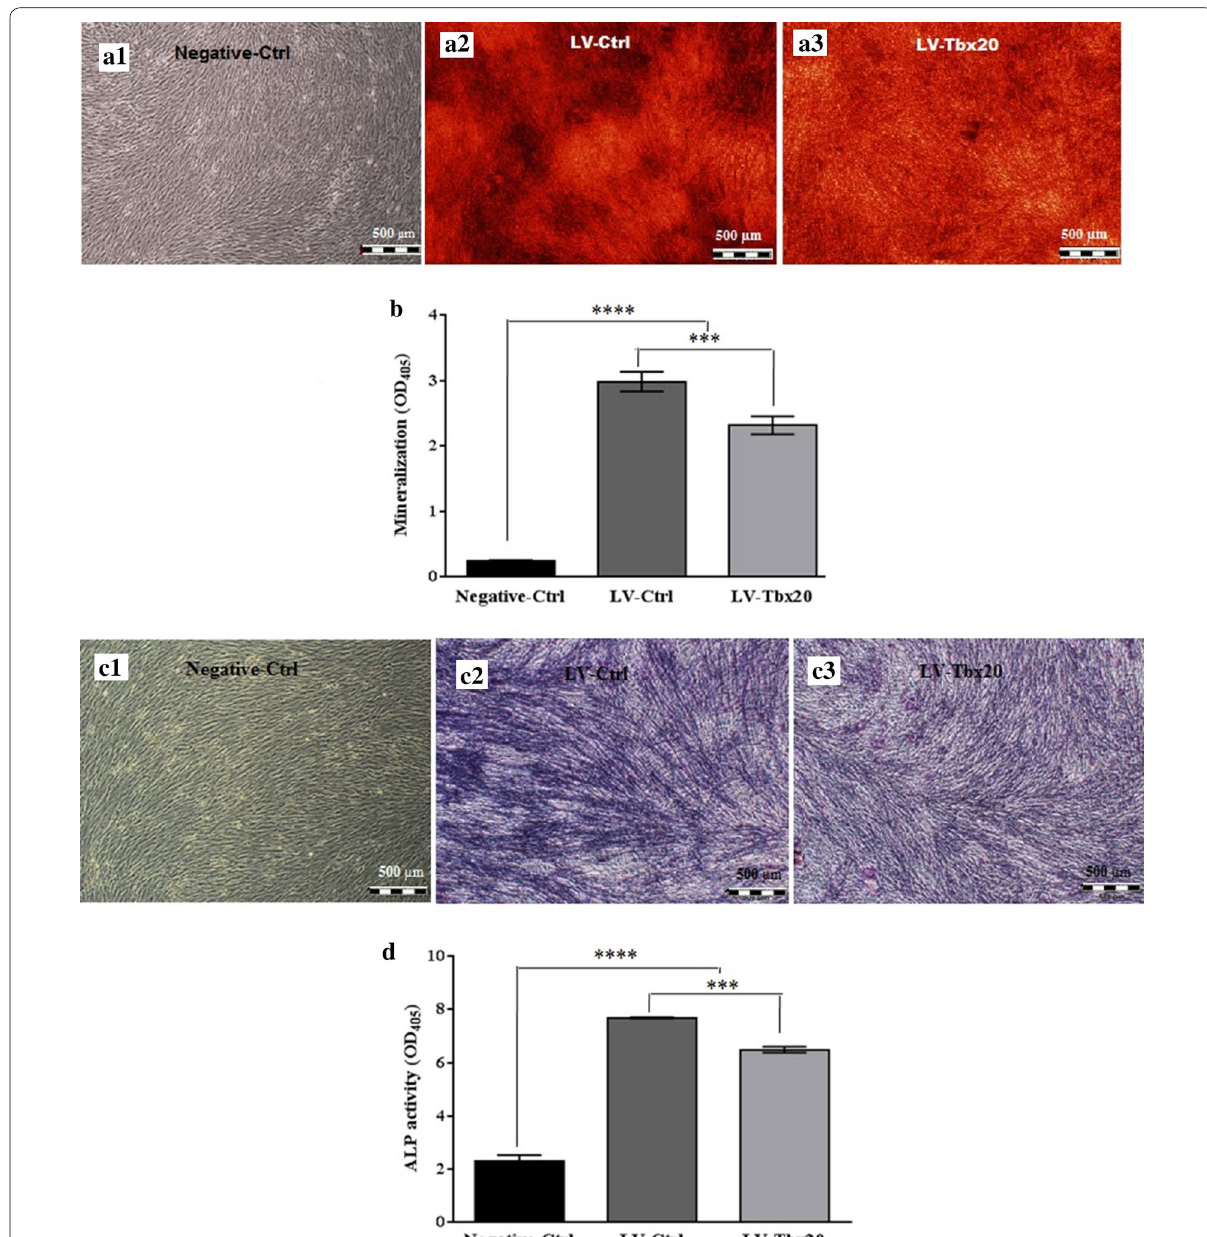
Fig. 3 Enhanced expression of Tbx20 in Ad‑MSCs reduced osteogenesis. Cells were infected with control viral vector (LV‑Ctrl) or LV‑ Tbx20 and allowed to differentiate in osteogenic medium. a After 21 days, mineral nodules deposition was stained with Alizarin Red S (ARS). b The stained cells were extracted using 10% acetic acid and its absorbance was read at 405 nm to quantify the mineralization level. c After 21 days, induced cells were stained with BCIP/NBT to detect secreted alkaline phosphatase. d After 7 and 14 days ALP activity was conducted using pNPP liquid substrate system. All data are presented as mean SD. ****Shows significant differences ( p < 0.0001) between negative control (cells grown in ± normal medium) and infected groups; ***Indicates significant differences ( p < 0.001) between LV‑Ctrl and LV‑ Tbx20 . Experiments were performed in triplicate and repeated three